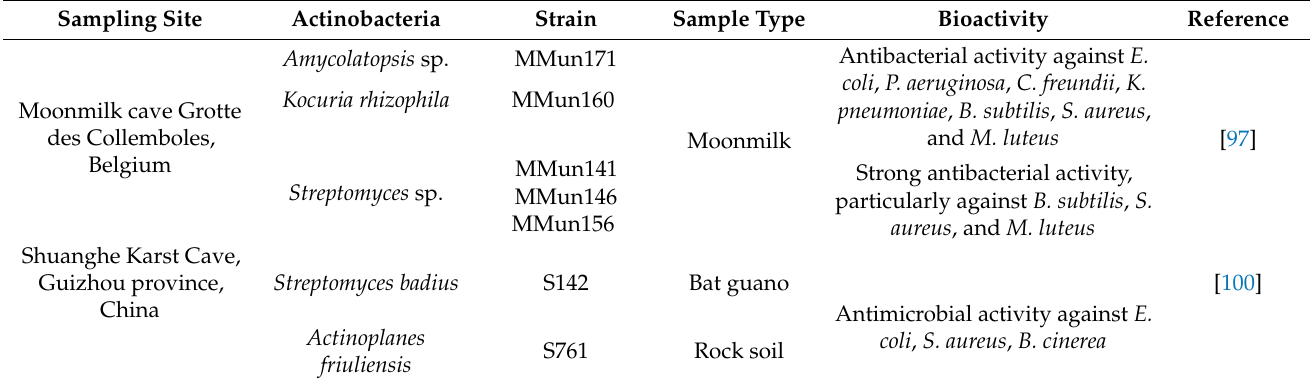
Table 3. Summary of bioactivity of actinobacterial strains isolated from